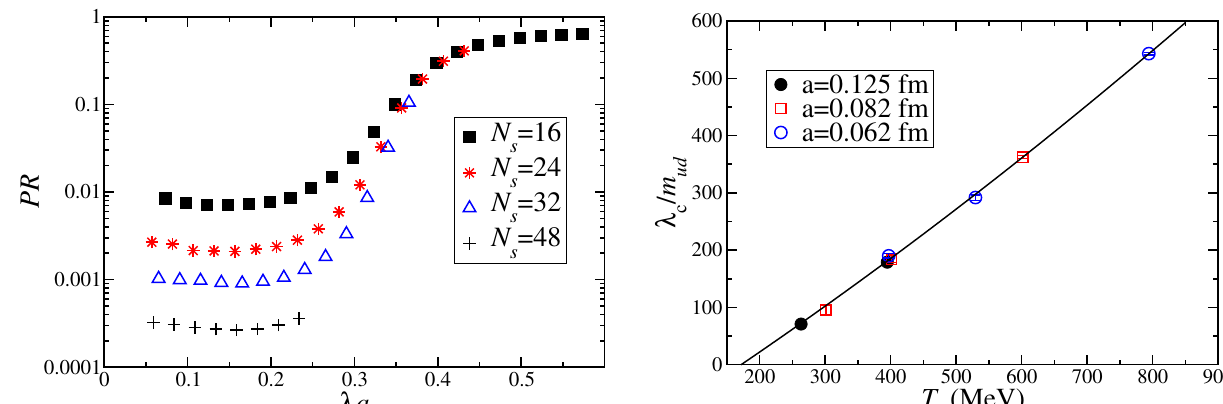
Figure 9. Average PR of the staggered Dirac modes as a function of the eigenvalue λ for various volumes at T = 394MeV, a = 0.125fm ( left ) and renormalized mobility edge λ c / m ud as a function of T ( right ) in 2+1 flavor QCD with staggered fermions and physical quark masses. From Ref. [33]. (Reprinted figures with permission from T.G. Kovács and F. Pittler, Phys. Rev. D 86, 114515 (2012). Copyright (2012) by the American Physical